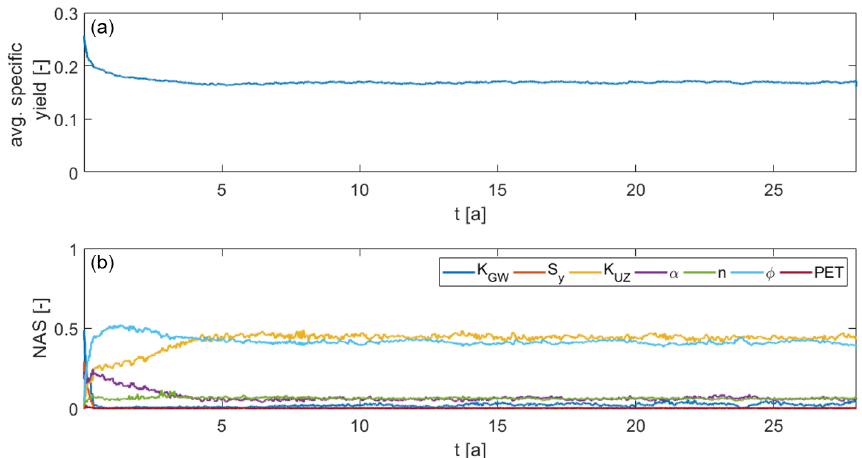
Figure 19. (a) Averaged specific yield values. (b) Transient normalized activity